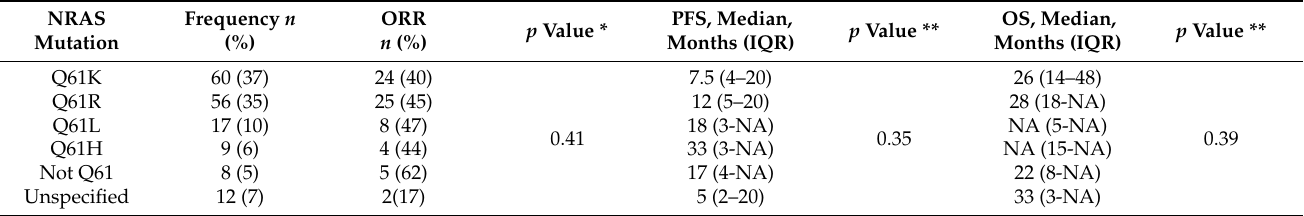
Table 5. Distribution of NRAS mutation genotypes and clinical outcome ( n = 162 patients).